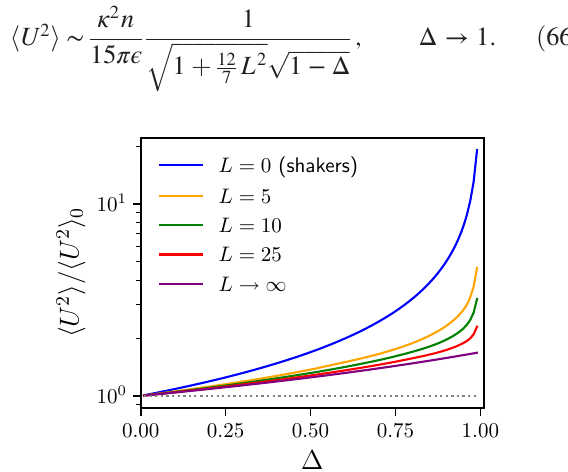
FIG. 1. The fluid velocity variance h U 2 i normalized by its noninteracting value h U 2 i 0 for various values of L . The dotted line represents the noninteracting case h U 2 i ¼ h U 2 i 0 . Note that the L → ∞ line turns sharply upward and diverges in the vicinity of Δ ¼ 1 in a way that cannot be resolved on the scale of this